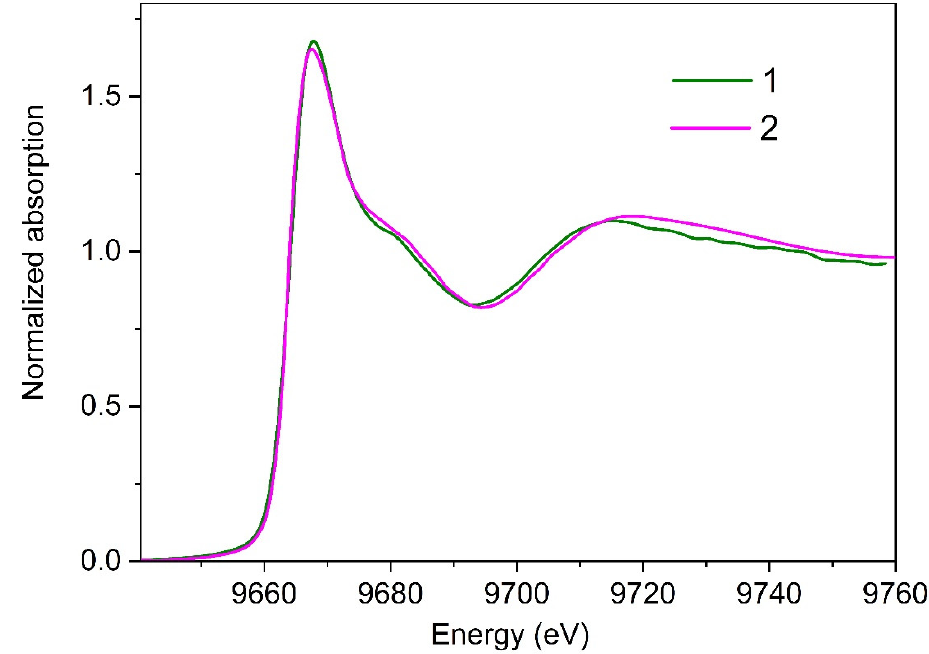
Figure 5. Zn K-edge XANES spectra for the parkin protein layer adsorbed at liquid interface, collected under high X-ray radiation load (Curve 1), and for the monolayer of Zn-containing enzyme alkaline phosphatase (Curve 2).